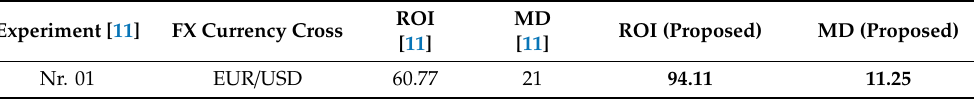
Figure 6. The GSM block: An instance of workflow (long trades). Table 1. Trading Performance Comparison.